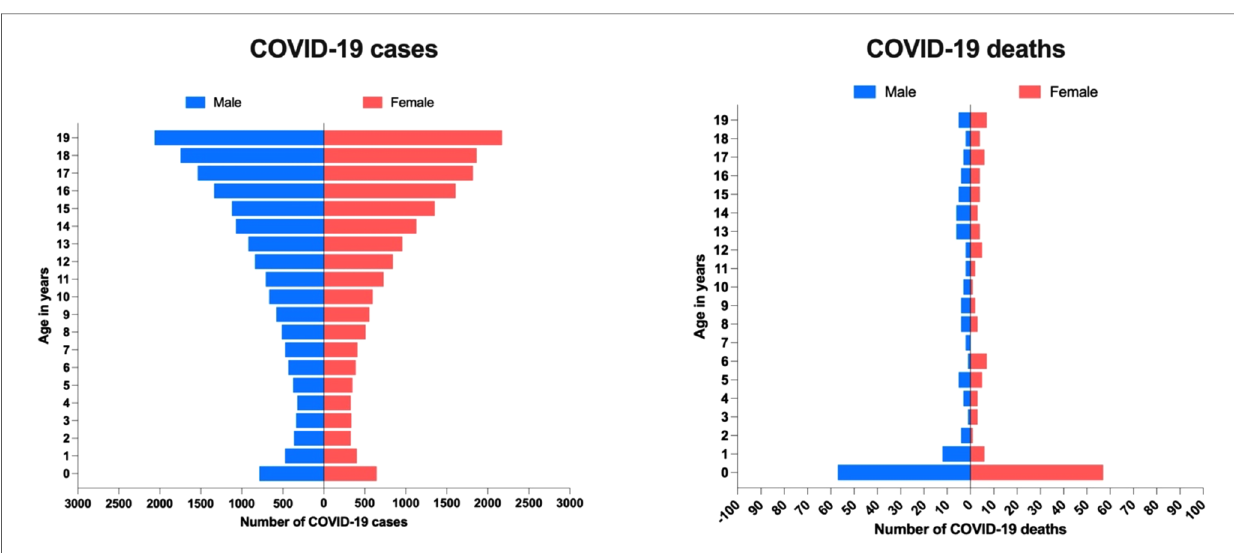
FIGURE 2 COVID-19 related cases and deaths by age among pediatric and adolescent population in